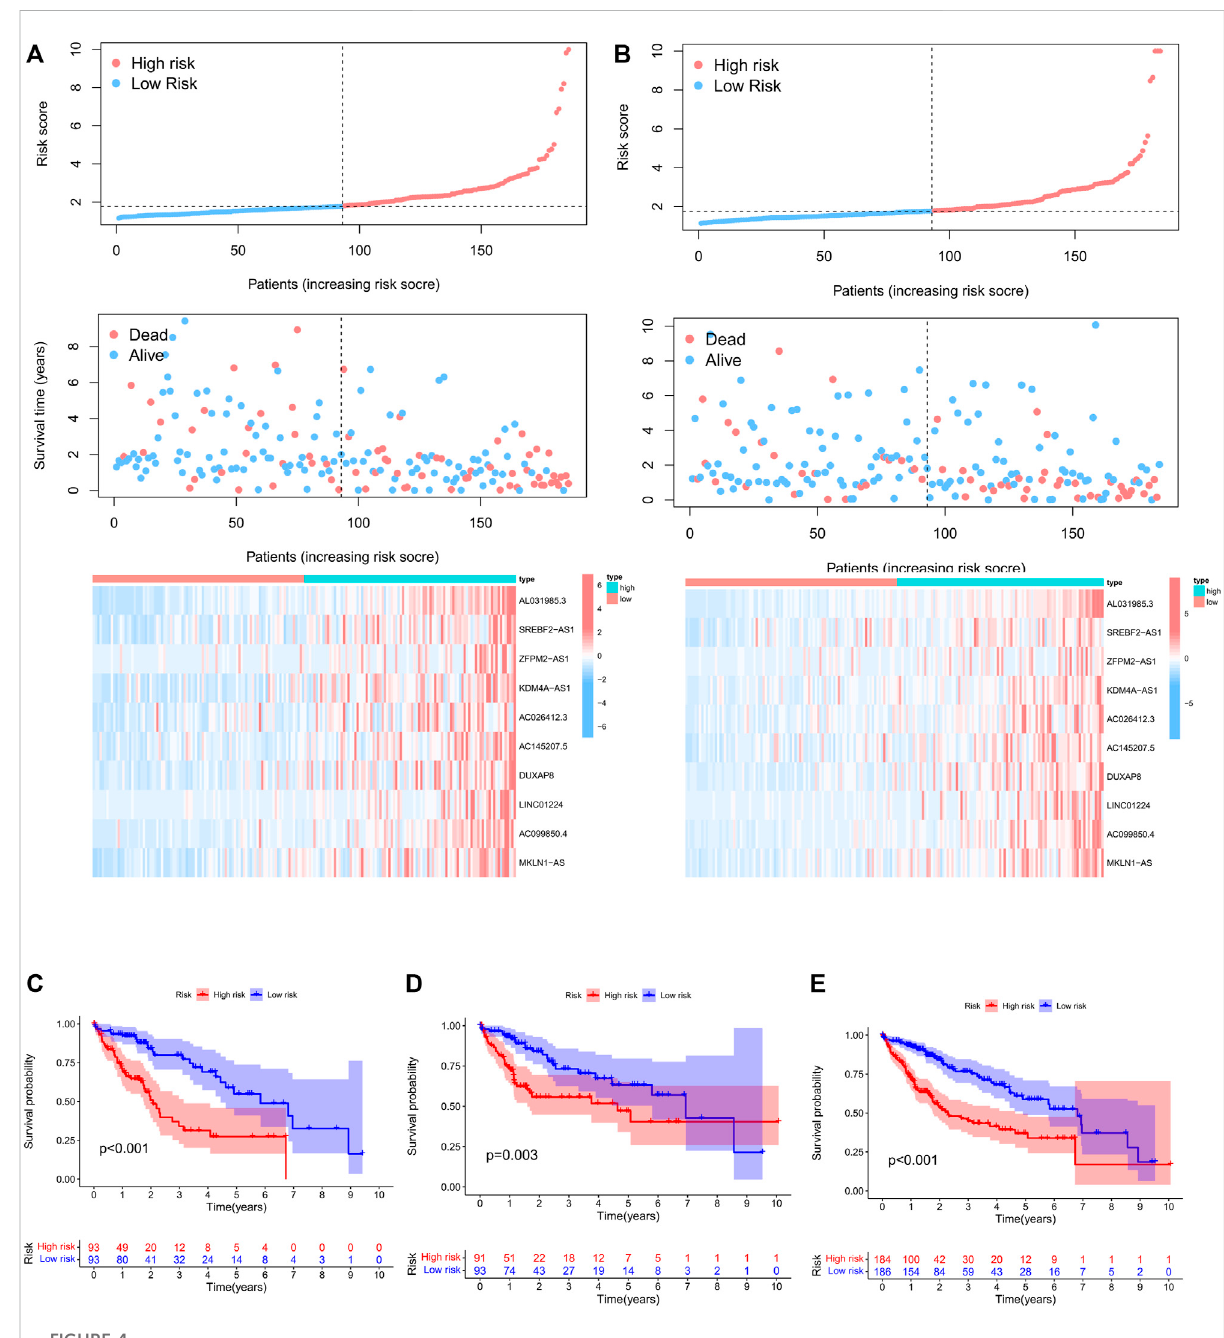
FIGURE 4 Constructionand validation ofprognostic PRlncRNAssignaturesinTCGA cohorts. (A) Riskfactorcurve,survivalstatus ofpatients, and heatmap of the differential expression of 10 PRlncRNAs in the TCGA training cohort. (B) Risk factor curve, survival status of patients, and heatmap of the differential expression of six PRlncRNAs in the TCGA test cohort. (C – E) Kaplan – Meier survival curves of the TCGA training cohort, internal validation cohort, and whole